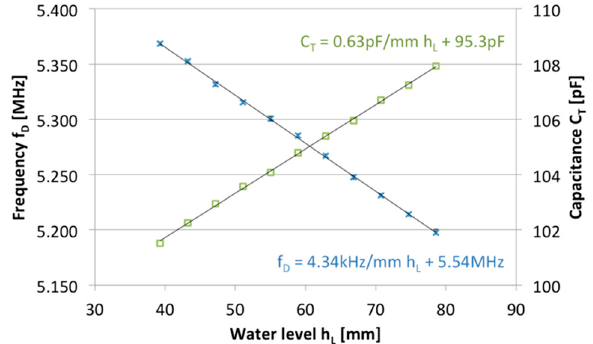
Figure 6. Measured damped frequency f D and measured total capacitance C T as a function of the water level h L